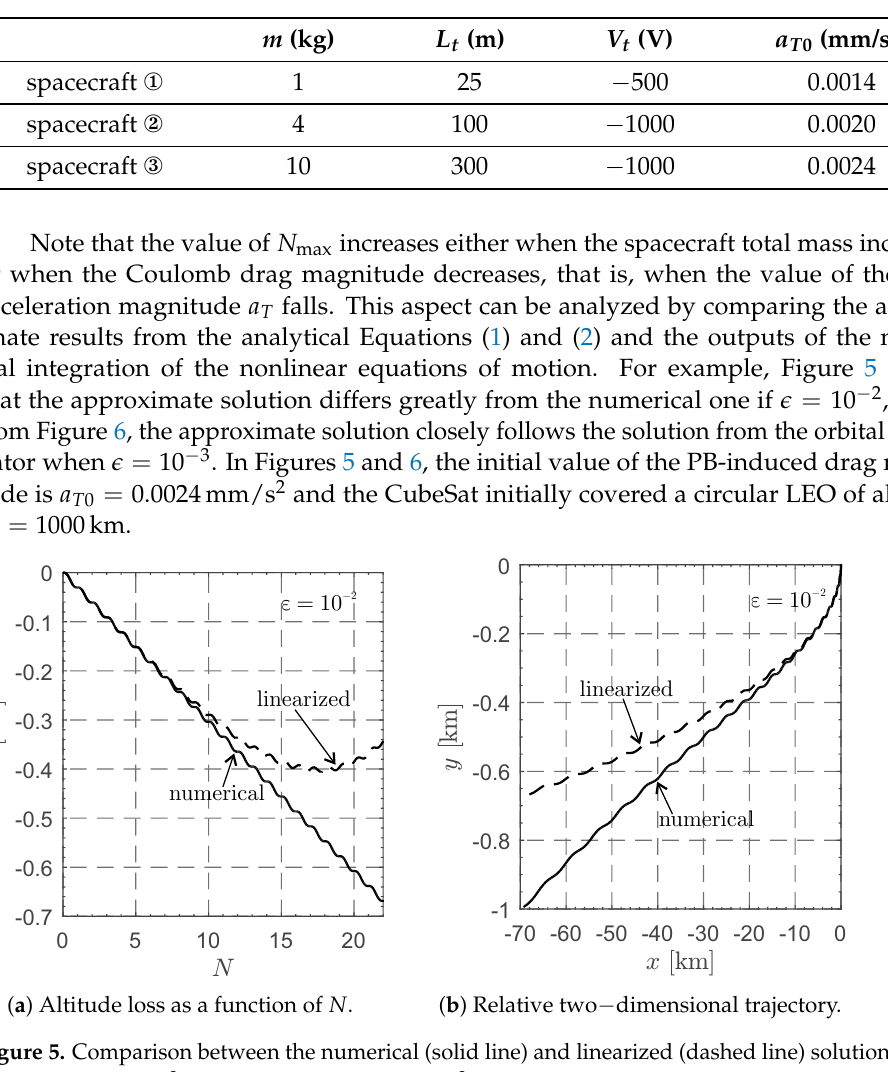
Table 1. Characteristics of the satellites in the PB-enabled deorbiting simulations when h 0 = 1000km.